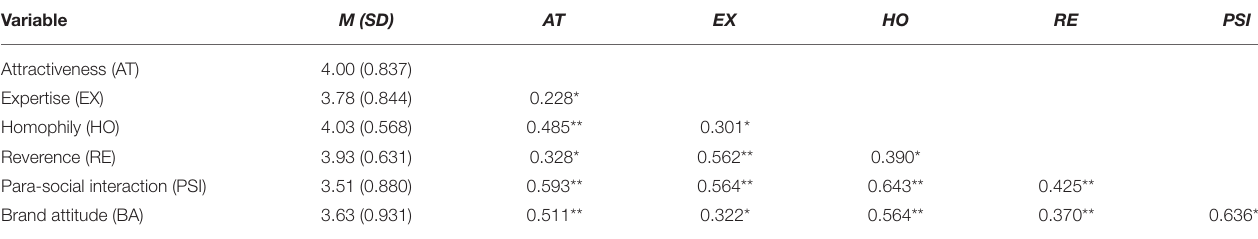
TABLE 3 | Variable correlations.